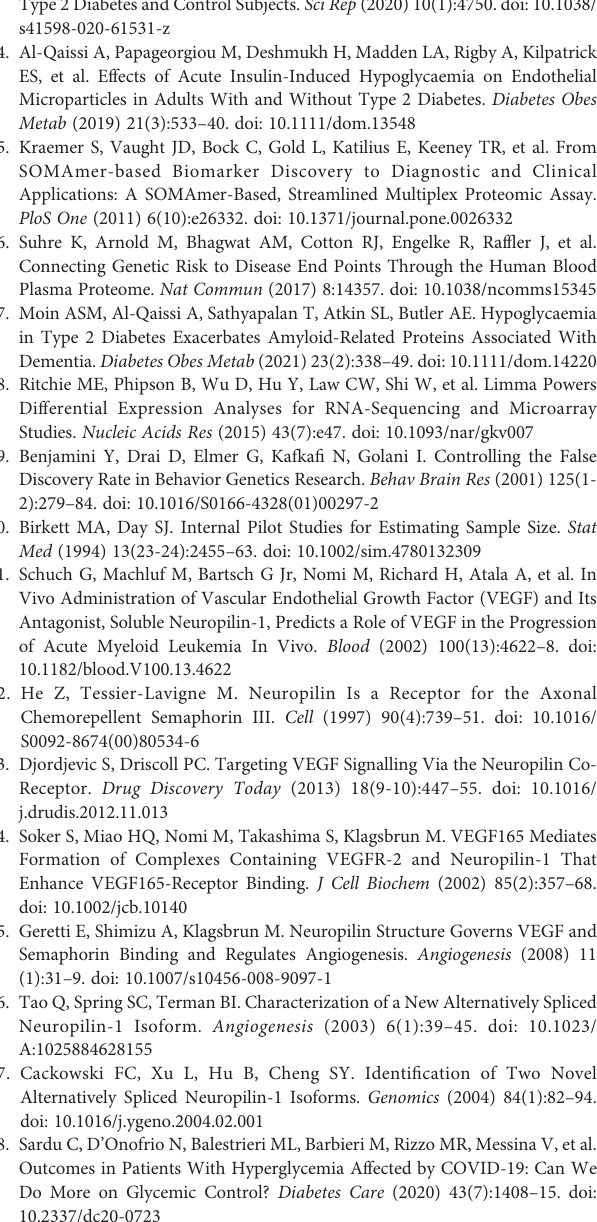
Supplementary Figure 1 | Correlation of change of blood glucose from normoglycemia to hyperglycemia with basal levels of renin angiotensinogen system (RAS) proteins, Renin, angiotensinogen (ANG) and angiotensin-converting enzyme 2 (ACE2) (A) and sNRP1 related proteins, sNRP1, VEGF, SEMA3A and ADAM17 (B) in T2D. No correlation of hyperglycemia with those proteins was found T2D subjects. Part A: Renin, open black circles; angiotensinogen (ANG), open blue squares; ACE2, open red diamonds. Part B: NRP1, open black circles; SEMA3A, open blue squares; ADAM9, open red diamonds; VEGF, open green triangles. Supplementary Figure 2 | Gender strati fi cation of RAS proteins or sNRP1 related proteins at baseline or at hypoglycemia. No signi fi cant differences between maleandfemaleinthelevelsofsNRP1,VEGF,SEMA3AorADAM17atbaselineand hypoglycemia in control (A, B) ; and at baseline, normoglycemia and hypoglycemia in T2D (C – E)